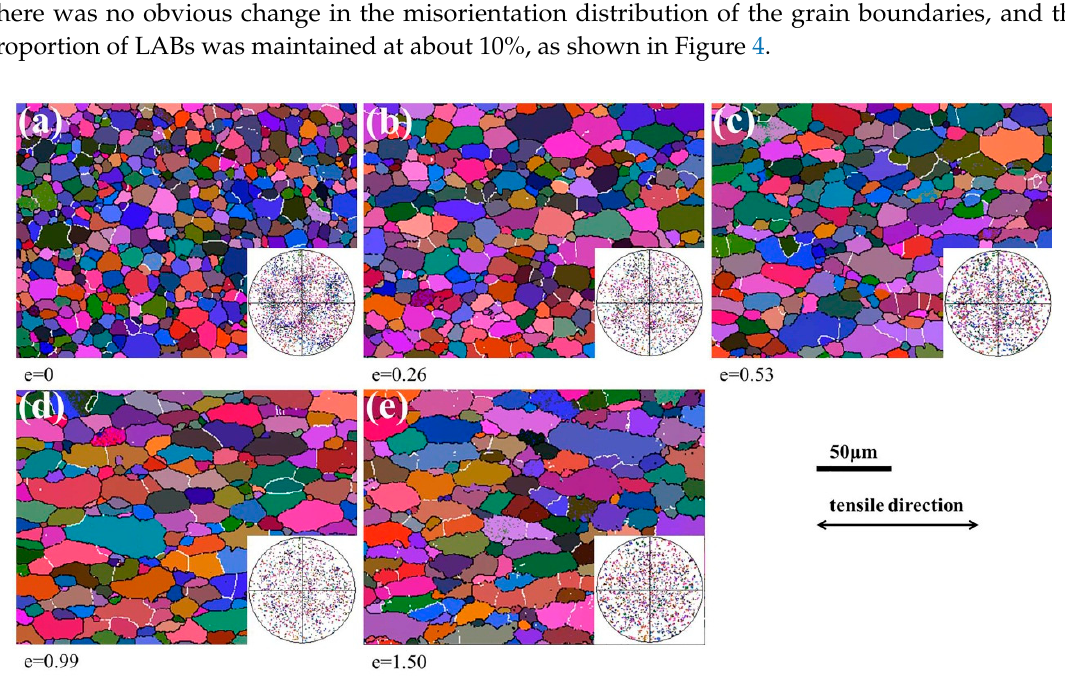
Figure 3. The EBSD orientation images and {110} pole figures after superplastic deformation at 490 °C and 2 × 10 − 4 s − 1 .